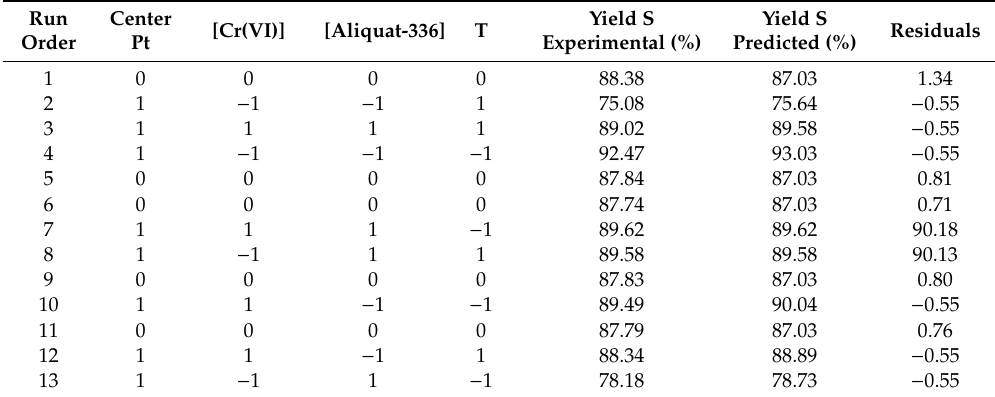
Table 4. Feed phase matrix of experiments.